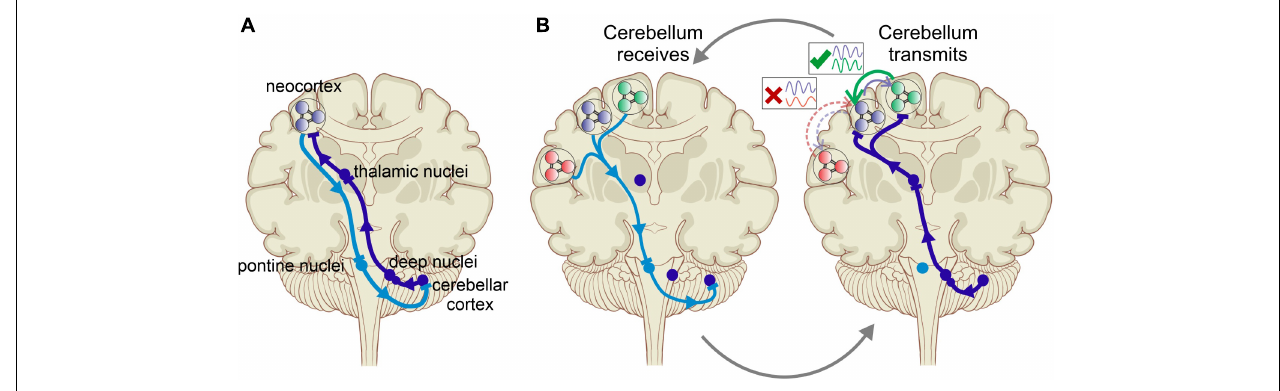
FIGURE 1 | (A) Cerebrocerebellar interaction via reciprocal connections between specific cerebral and cerebellar areas. Purkinje cells in the cerebellar cortex project to the neocortical areas via the cerebellar nuclei and the thalamus. In what was often described as a closed-loop projection, the neocortex in turn projects back to the cerebellar area of origin via the pontine nuclei. This one-to-one interaction scheme is the basis of most approaches to investigating cerebrocerebellar interactions. (B) Cerebellar modulation of communication between cerebral cortical areas provides a revised picture of cerebrocerebellar interactions, in which the cerebellum does not primarily modulate the activity in specific cortical areas but rather coordinates the communication between areas by augmenting the coherence of neuronal oscillations in a task specific manner. This occurs cyclically with the cerebellum areas receiving the neuronal “context” of cerebral activity from multiple regions by encoding their oscillations, comparing their timing, and then transmitting the output via the thalamus to promote synchrony between task-appropriate cerebral cortical